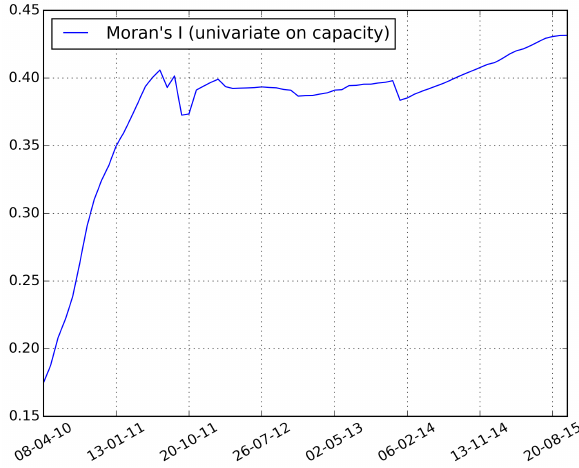
Figure 6. Moran’s I for the capacity of domestic PV installations per PCD over